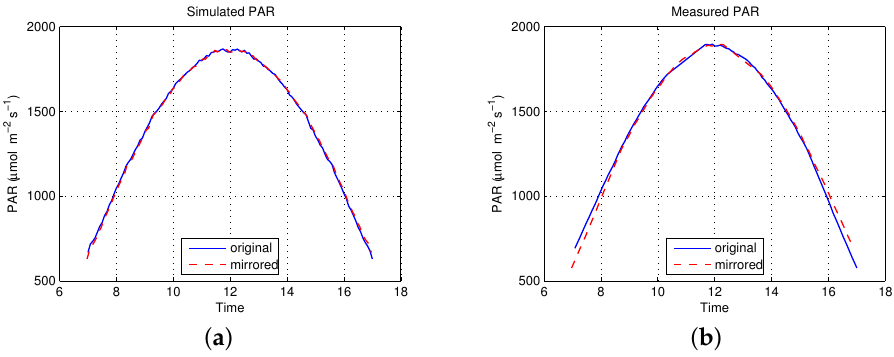
Figure 10. An example of the original and horizontally mirrored PAR: ( a ) simulated PAR and ( b ) measured PAR.